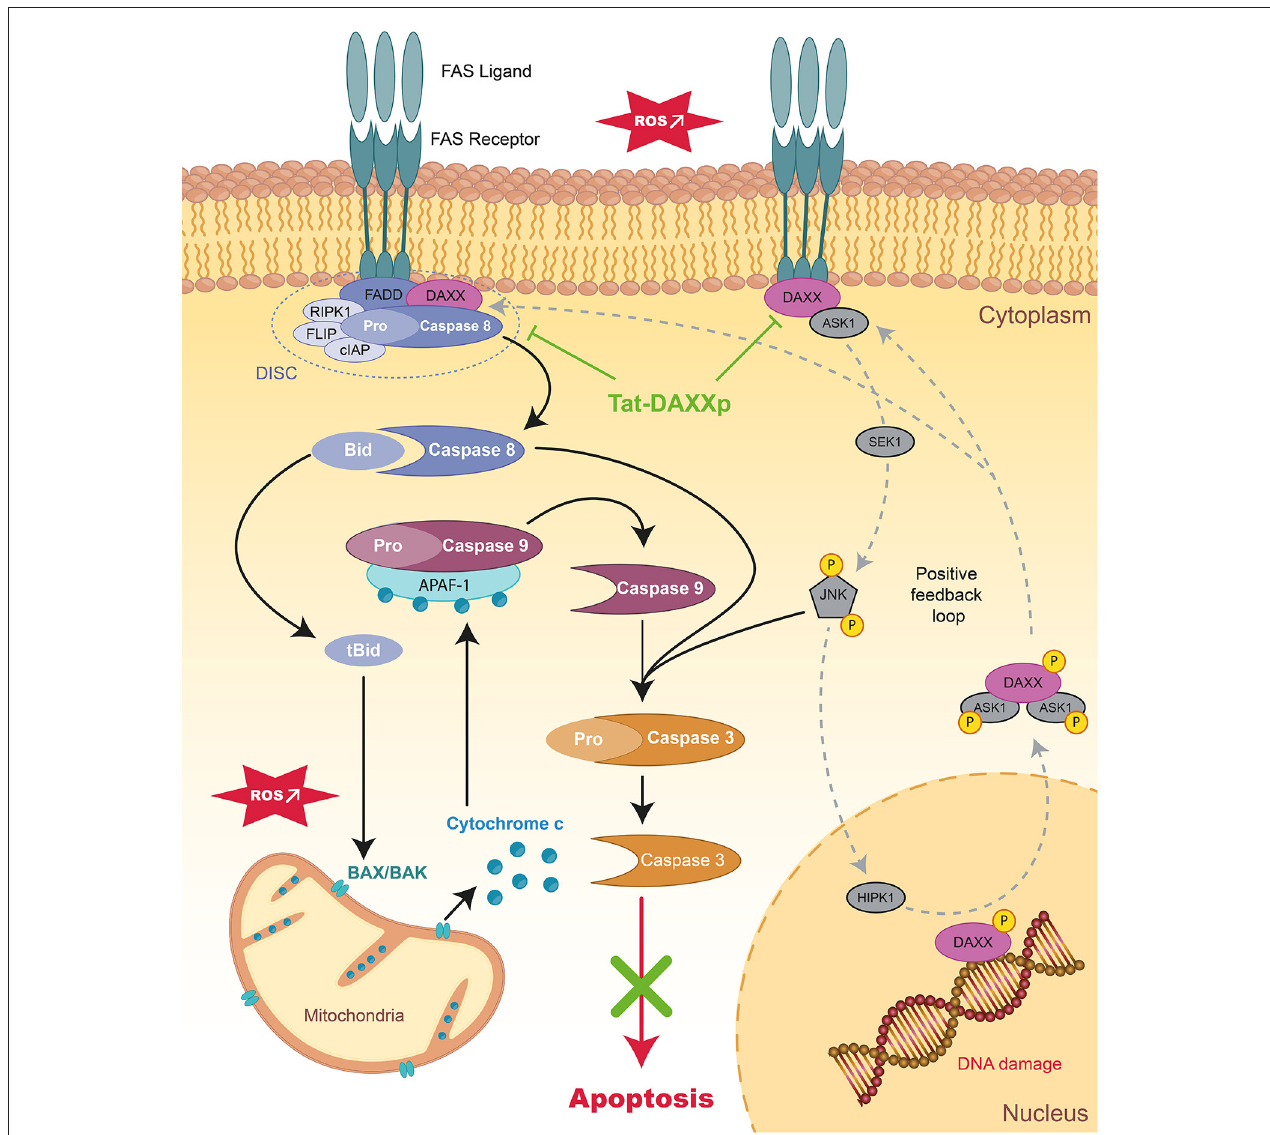
FIGURE 2 | Schematic representation of extrinsic apoptotic pathways and mode of action of therapeutic peptides during MIRI. Schema presenting the signaling apoptotic cascades activated during MIIR involving receptor-dependent pathways in the myocardium. The positive feedback loops regulating DAXX nucleic-cytoplasmic ratio is showed in dark gray. Tat-DAXXp treatment administered at the onset of reperfusion (highlighted in green) can inhibit both the extrinsic and intrinsic pathways. FAS, First Apoptosis Signal; FADD, Fas-Associated protein with Death Domain; DAXX, Death-domain associated protein-6; DISC, death-inducing signaling complex; RIPK1/3, Receptor-interacting serine/threonine-protein kinase 1/3; FLIP, FLICE-inhibitory protein; cIAP, cellular inhibitor of apoptosis proteins 1; ASK1, Apoptosis Signal regulating Kinase 1; JNK, c-Jun N-terminal Kinase; HIPK, homeodomain-interacting protein